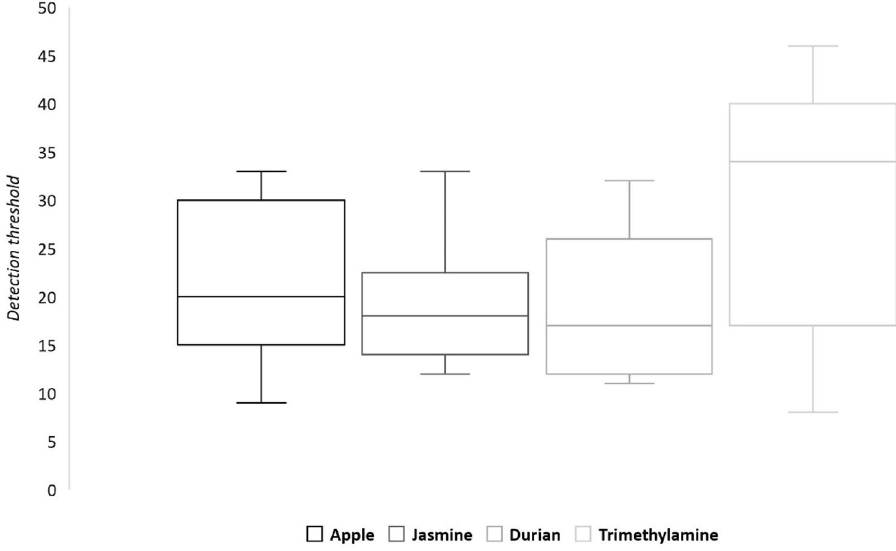
Figure 1. Boxplots of the IDT for apple, jasmine, durian, and trimethylamine odorants. In each boxplot, the middle line of the box corresponds the mean of odor detection threshold, the inferior line of the box corresponds to the first quartile, and the upper line of the box corresponds to the third